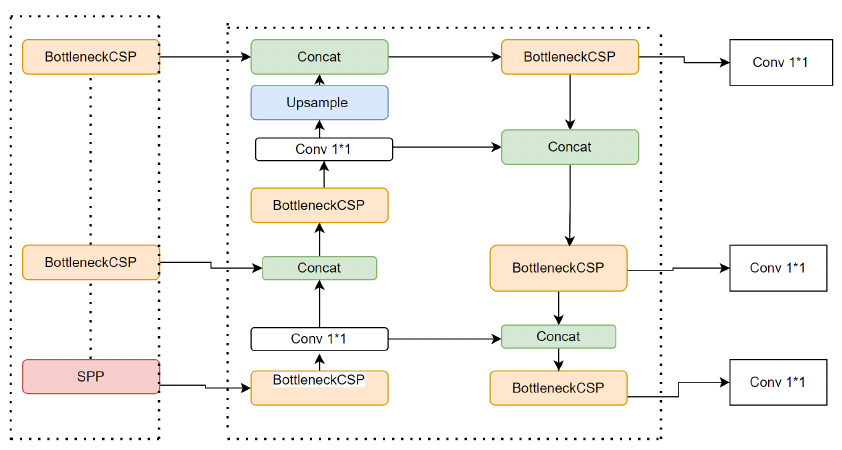
Figure 9. Overview of